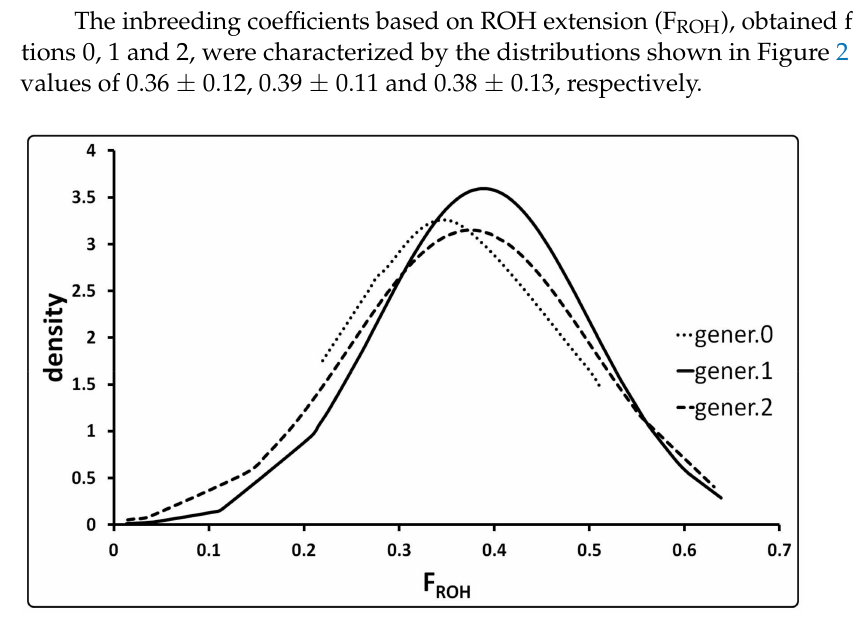
Figure 2. Distribution of the F ROH (inbreeding coefficient using Runs of Homozygosity) values in the three generations of Nero Lucano